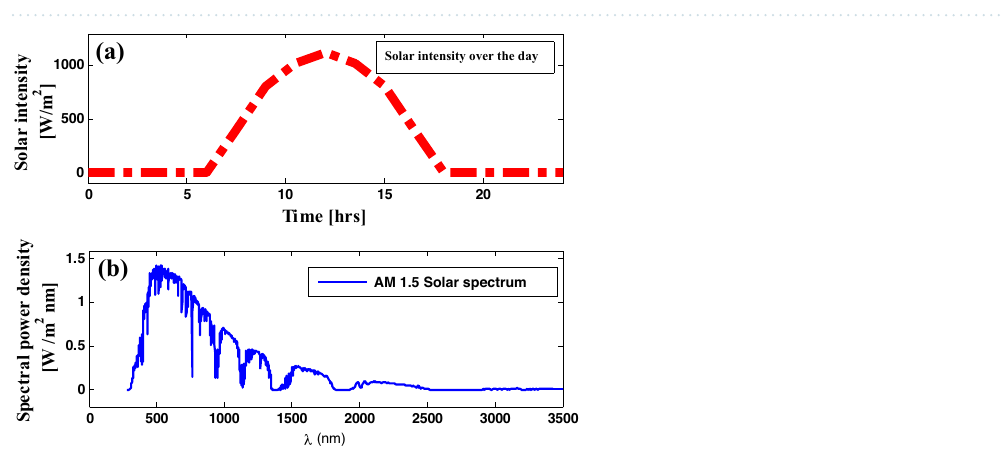
Figure 4. ( a ) the solar power intensity during the time of the day; ( b ) the solar spectrum AM 1.5 G, with the part of the solar spectrum that may ideally be utilized by thermal water